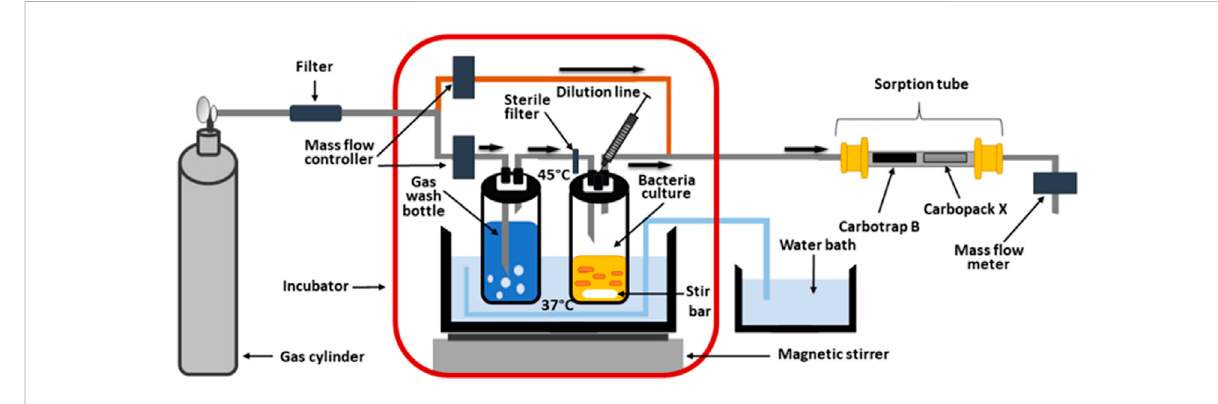
FIGURE 1 In-house-made system for cultivation of bacteria with simultaneous preconcentration of headspace gas on sorption